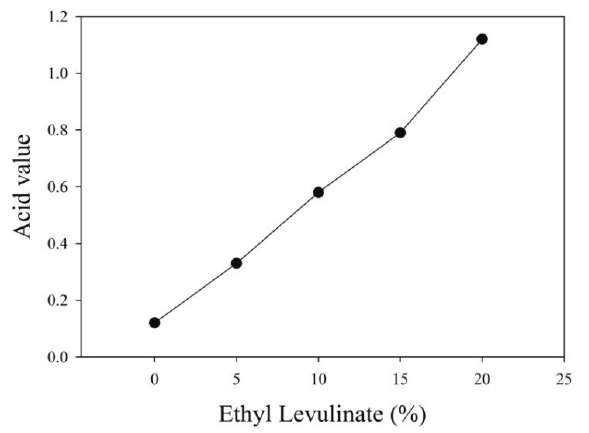
Figure 3: Effect of ethly levulinate amount on the acid value.